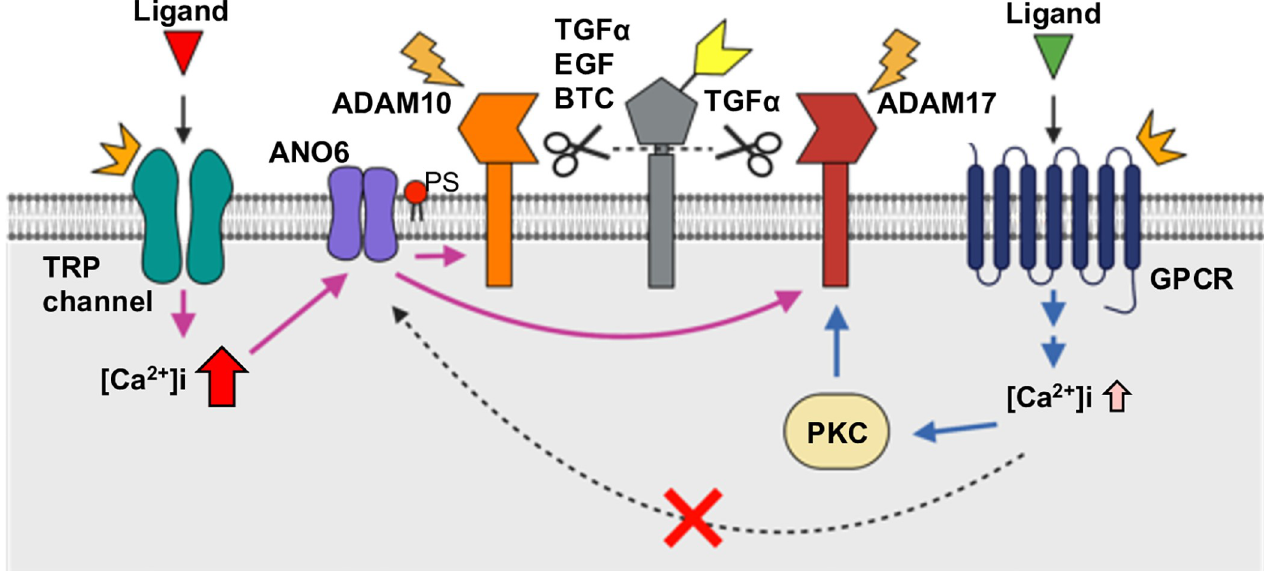
Fig 3. Possible mechanisms underlying ectodomain shedding of EGFR ligands by TRP channel and GPCR activation. Putative molecular mechanisms for ectodomain shedding of EGFR ligands by TRP channels and Gq-coupled GPCRs activation. ADAM, a disintegrin and metalloproteinase domain-containing protein; ANO6, anoctamin 6; BTC, betacellulin; EGF, epidermal growth factor; GPCR, G protein–coupled receptor; PKC, protein kinase C; PS, phosphatidylserine; TGF α , transforming growth factor alpha; TRP, transient receptor potential.